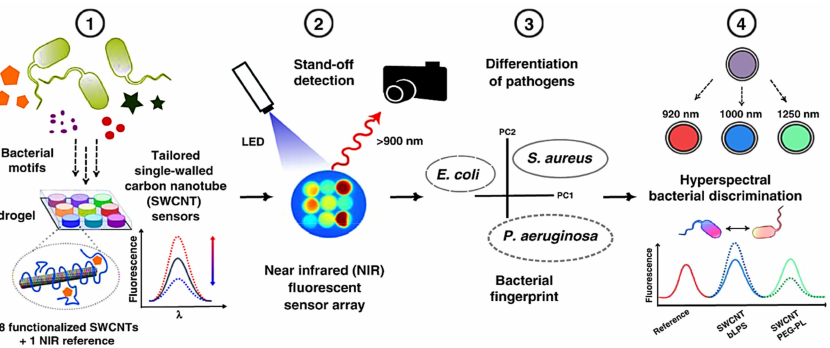
Figure 5. A schematic diagram for identification of pathogens. ( 1 ) SWCNTs-based nanosensor in the presence of pathogens produce a specific fluorescence signal, ( 2 ) PEG based-hydrogel with 8 fluorescent sensors remotely observed in NIR, ( 3 ) Growth of pathogens on hydrogel sensor change sensor array fingerprint and can discriminate different infections, ( 4 ) Multimodal nanosensors can specify for detection and discriminate different pathogens. Reprinted from Ref.